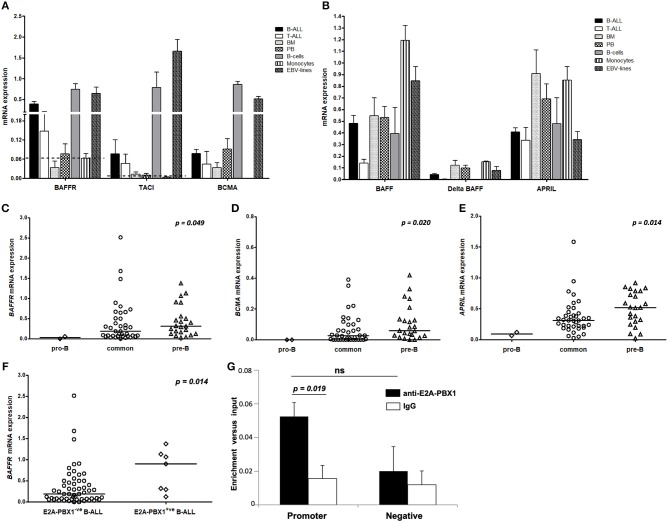
Pattern of mRNA expression of BAFF/APRIL system and E2A-PBX1 binding to BAFFR promoter. For (A–F) the vertical axis represents the normalized relative gene expression values. (A) Receptors and (B) ligands mRNA levels in patients with B- (n = 63) and T- (n = 7) lineage ALL and in mononuclear cells from BM (n = 4), PB (n = 5), pure mature B-cells (n = 3) and pure monocytes (n = 3) from healthy donors, and EBV cell lines (n = 4). The bars represent mean values and the lines the standard error of mean. The discontinuous lines represent the relative mRNA expression of receptors in monocytes that serve as a negative control group. (C)
BAFFR, (D)
BCMA, and (E)
APRIL mRNA levels are correlated with the maturation stage of B-lymphoblasts. The lines in the dot plots represent the median value for each B-ALL subtype; p-value in each plot refers to Kruskal-Wallis H test. (F) Increased BAFFR transcript levels in patients with pre-B-ALL carrying the E2A-PBX1 translocation; p-value refers to Mann-Whitney U test. (G) E2A-PBX1 binding to the promoter of BAFFR gene in the pre-B-ALL cell line 697. Cross-linked chromatin from 697 cells was used in ChIPs with anti-E2A-PBX1 antibody. IgG was utilized in parallel with anti-E2A-PBX1 antibody, as control. Two sets of primers were used: One set specific for the amplification of the BAFFR gene promoter and one set of negative control primers for amplification of a region lacking PBX motifs. Bars represent mean and standard error values of specific enrichments (fold differences) vs. input obtained in at least three independent experiments. The statistical significance (Student's t-tests) of the difference of enrichment for promoter sequences vs. the IgG control (p = 0.019) and negative control region (ns, not significant) are indicated.